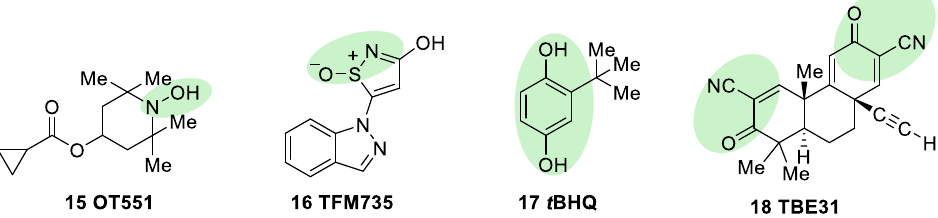
Figure 10. Chemical structures of OT551, TFM735, t BHQ, and TBE31. Their electrophilic moieties or promoieties are highlighted in green.